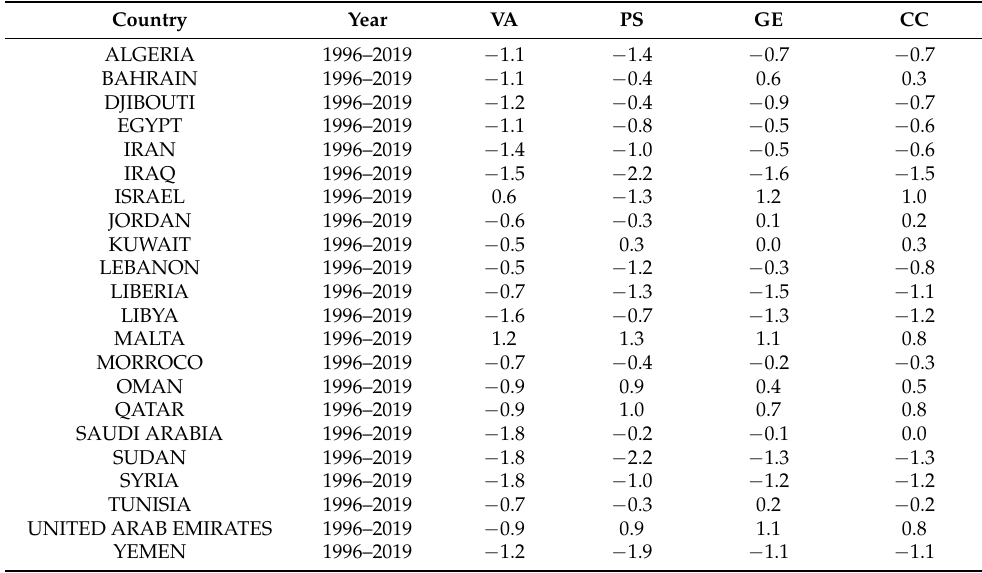
Table A5. Institutional quality